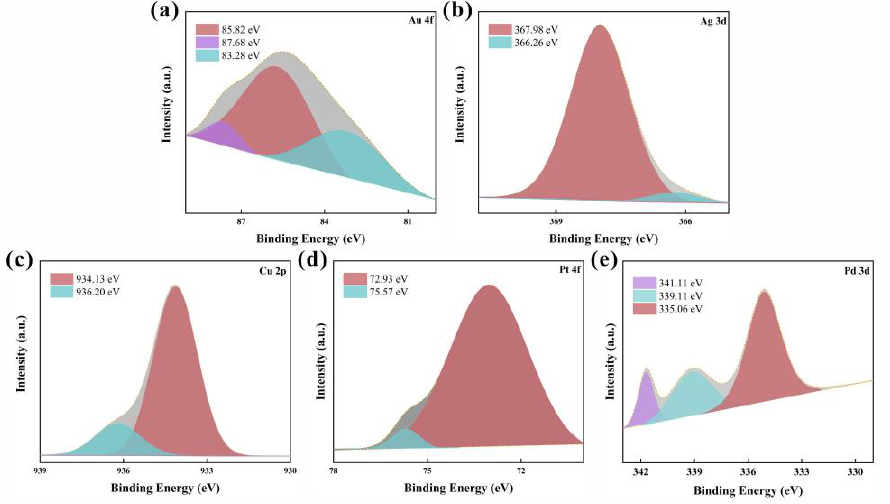
Figure 5. XPS spectra of NM/BVO samples: ( a )Au 4f, ( b ) Ag 3d, ( c ) Cu 2p, ( d ) Pt 4f, ( e ) Pd 3d. Table 1. Surface composition of bare and modified BVO samples determined by XPS analysis. Samples